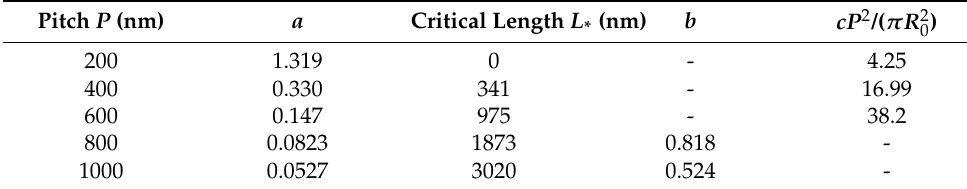
Figure 1. NW length versus deposition thickness at a fixed NW radius of 30 nm for different pitches shown in the legend. The dashed line corresponds to a diffusion length 𝜆 (cid:2871)(cid:3031)(cid:3032)(cid:3046) of 1500 nm. Table 1. Parameters of pitch-dependent NW growth kinetics.